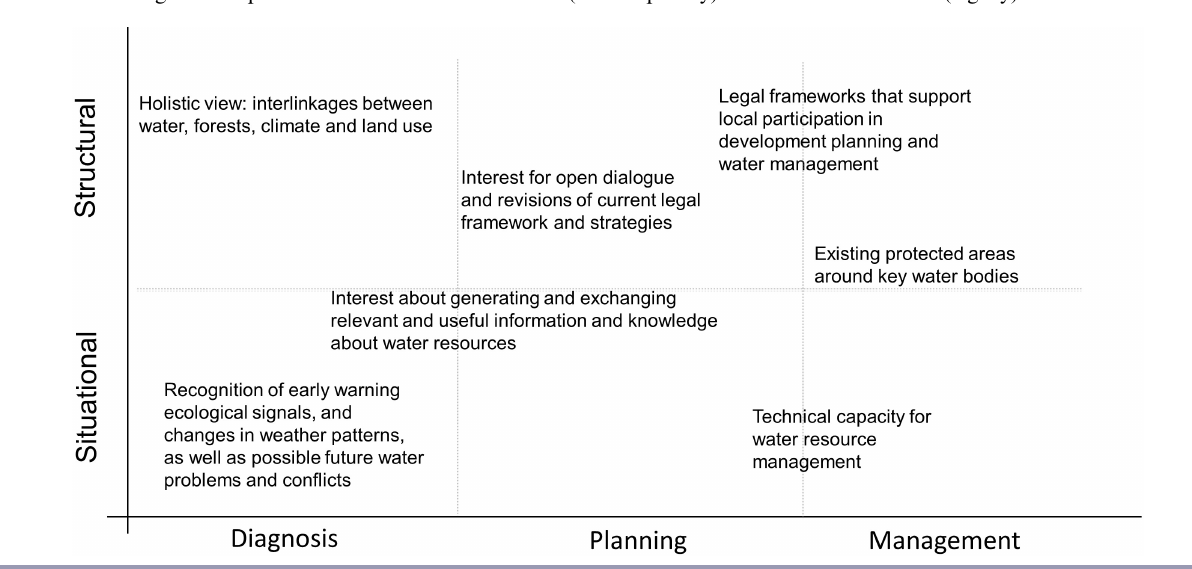
Fig. 4. Categorization of the points of intervention that could help overcome barriers to adaptation decision making for water security in the three model forests. The x-axis organizes the suggested interventions in terms of their relevance to the formal phases of adaptation decision making. The y-axis separates the interventions according to their potential to overcome situational (contemporary) barriers and structural (legacy)